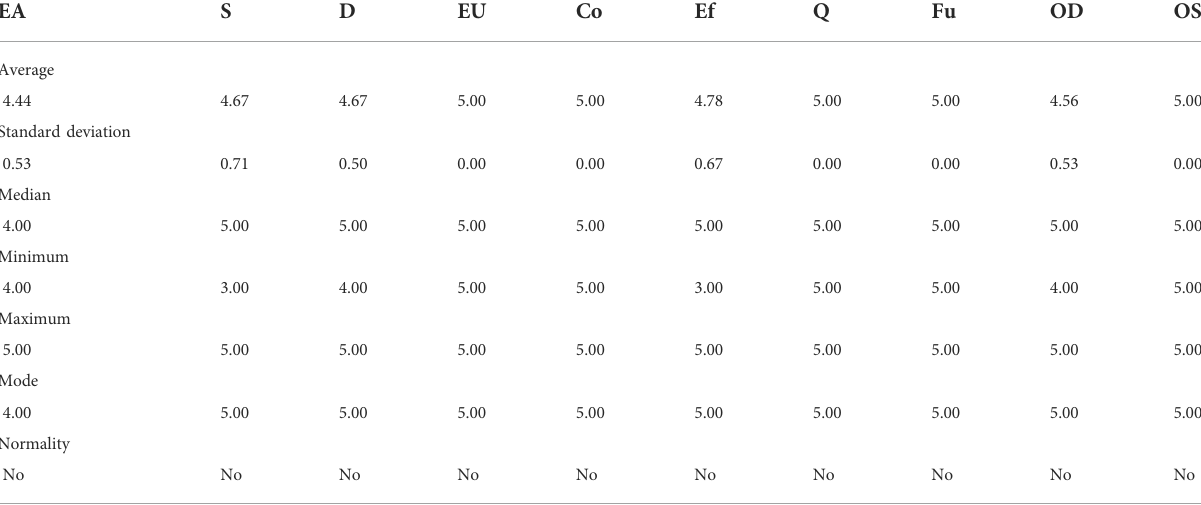
TABLE 7 Values of mean, standard deviation, median, minimum, maximum, mode and normality of QUEST results.